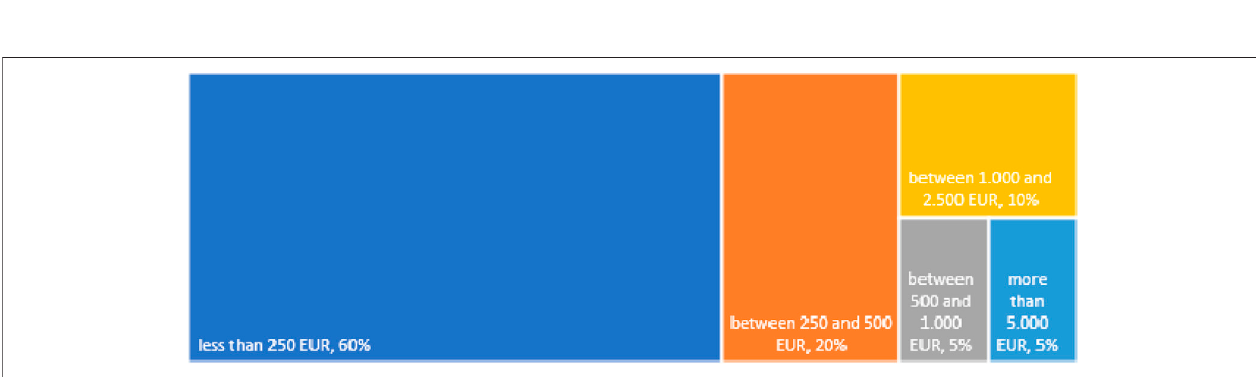
Frontiers in Future Transportation |